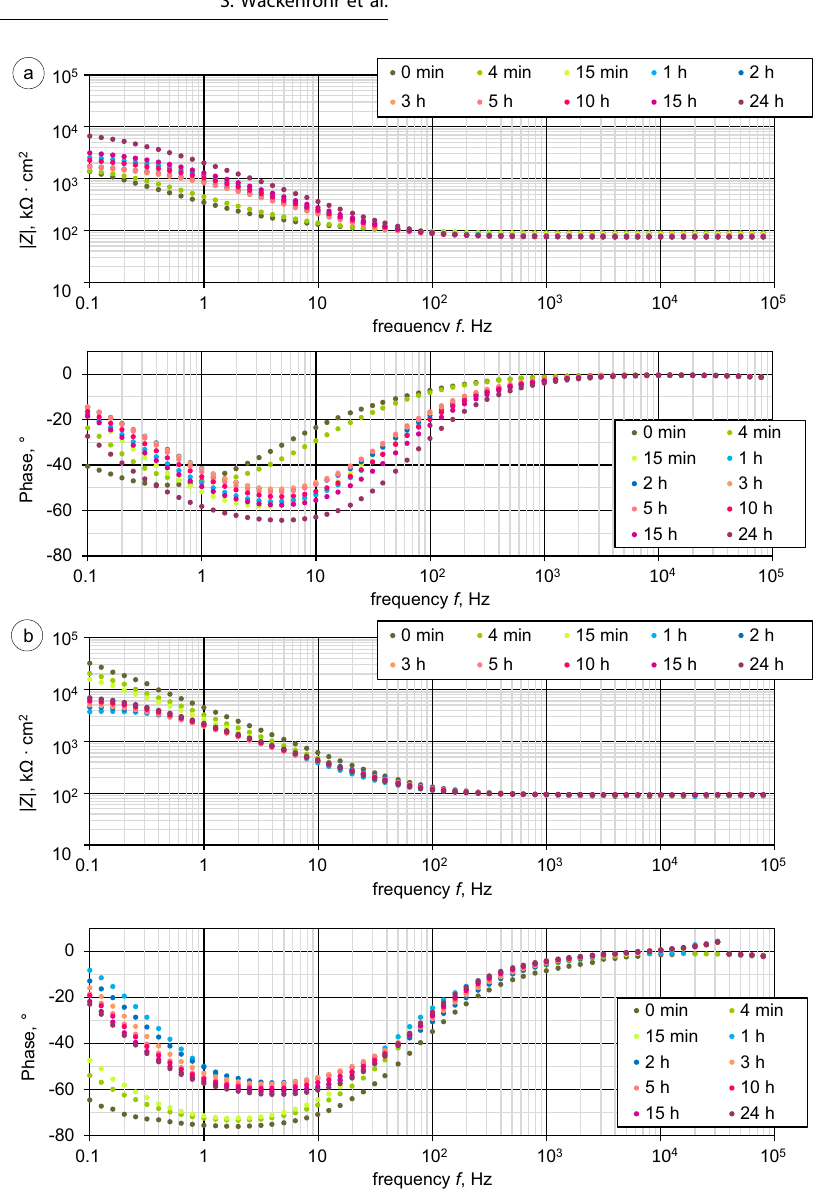
Fig. 9 Evolution of EIS data. Shown for a HR iron and b EBM iron upon immersion in m-SBF solution.